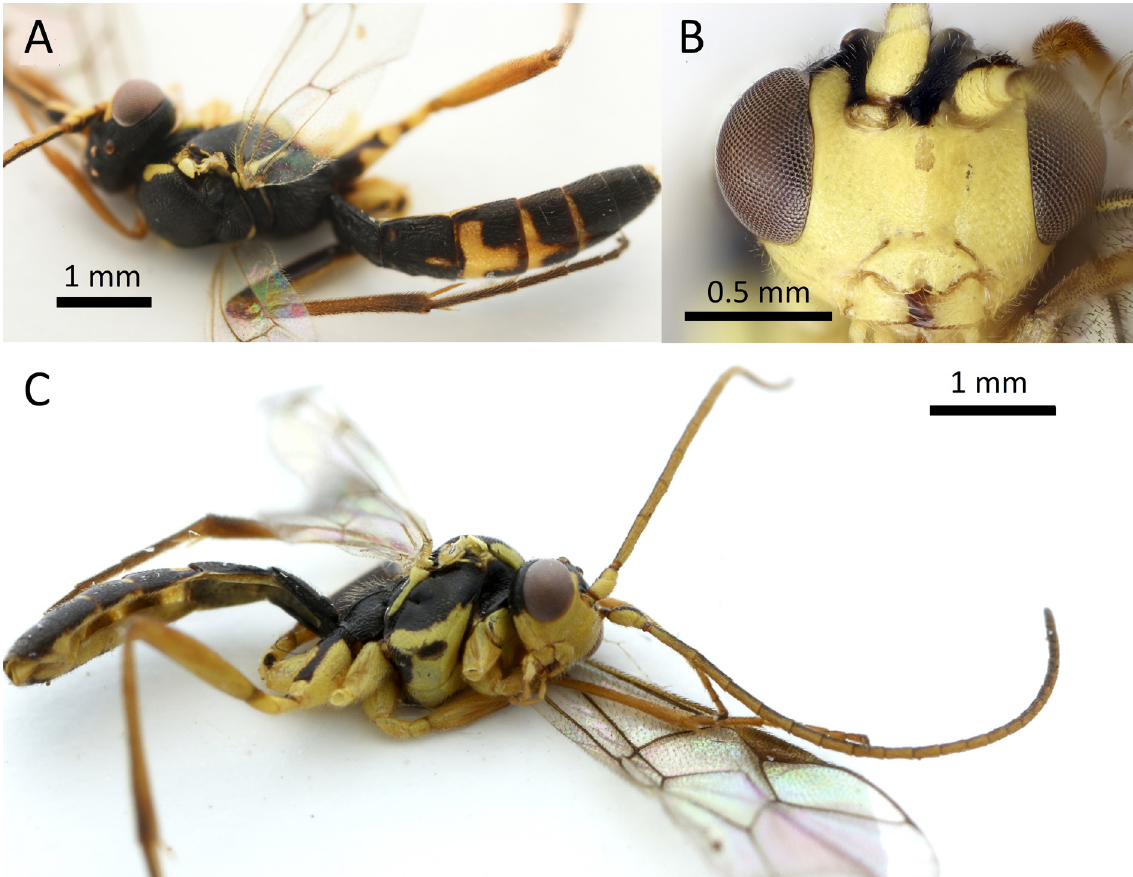
Fig. 9. Woldstedtius aureotibialis sp. nov., holotype, ♂ (NHRS-HEVA000011631). A . Habitus, laterodorsal view. B . Head, anterior view. C . Habitus, lateroventral